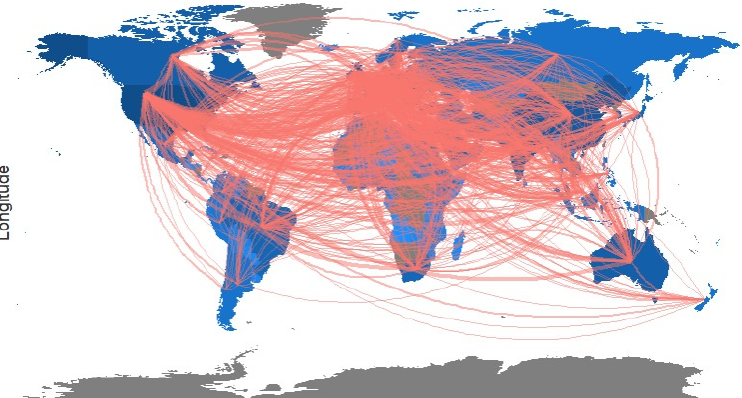
Figure 8. The Geographical map of the collaboration of countries in the research of the COVID-19 vaccine research (Dark blue color: countries with a high number of articles related to the COVID-19 vaccine, light blue color: countries with a low number of articles related to the COVID-19 vaccine, gray color: countries without articles related to the COVID-19 vaccine). Table 4. The most prolific journals in COVID-19 vaccine research. (IF: Impact factor, Q: Quarterly